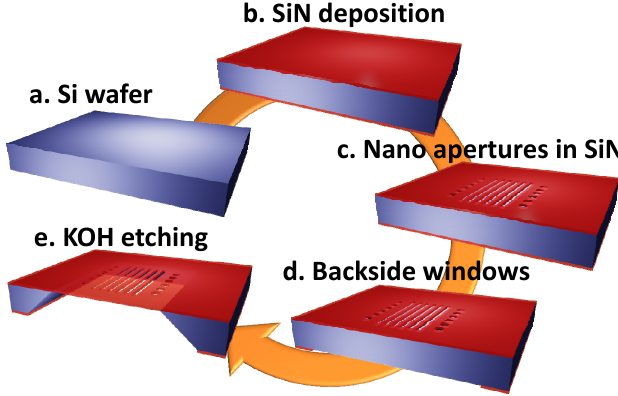
Figure 1. Simplified stencil fabrication process flow. The fabrication starts with ( a ) double side polished silicon wafers, where a layer of low stress silicon nitride (LS-SiN) is deposited on both sides of the wafer ( b ). The thickness depends on the particular dimension requirements of the application. ( c ) LS-SiN is patterned on the front side by using electron beam lithography (EBL) and reactive ion etching. ( d ) LS-SiN is patterned on the backside in order to define the windows for the subsequent KOH etching ( e ), which actually releases the